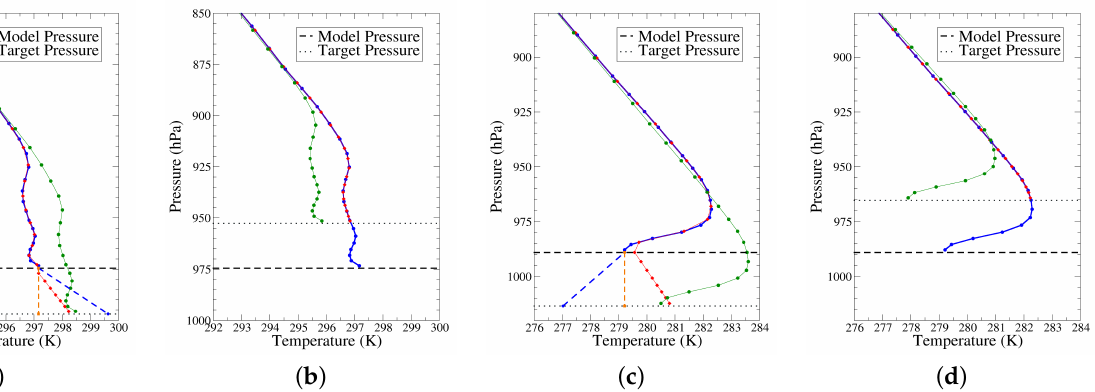
Figure 3. Temperature profiles provided by different extrapolations with zero gradient in orange, last gradient in blue, standard gradient in red and APACHE method in green. The original profile defined only above the model topography corresponds to the blue points above the model ground pressure. Two examples: the first one over Africa, the second over the Alps. ( a , c ) with a target below the model topography, ( b , d ) with a target above the model